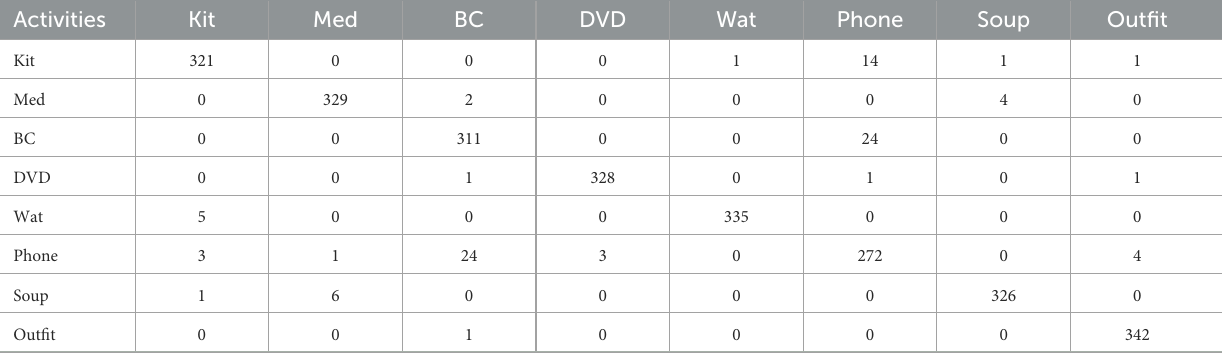
TABLE 5 Confusion matrix of XAI-HAR for activities in the CASAS dataset